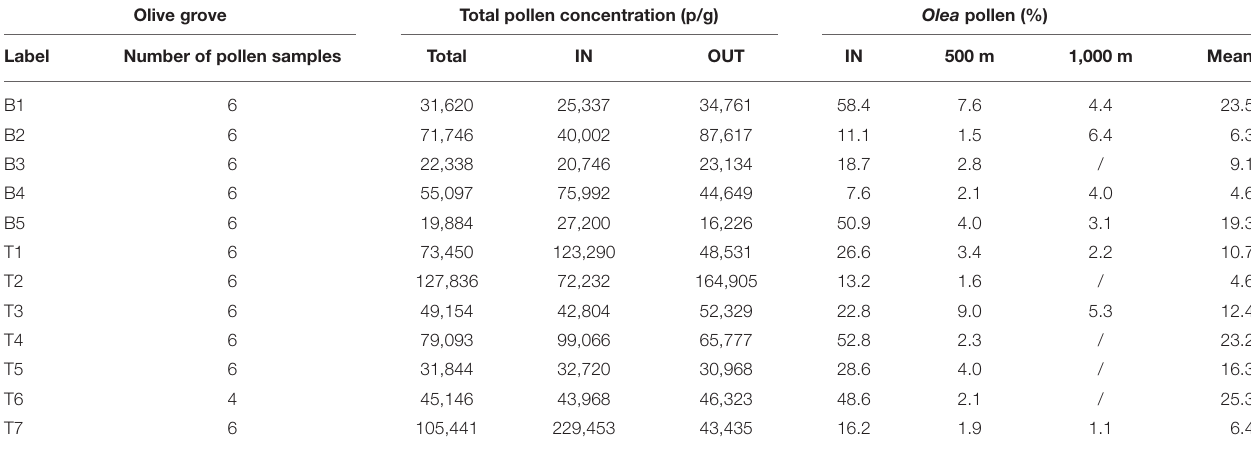
TABLE 2 | Results of the pollen analyses: concentration (p/g = pollen per gram) of all the pollen grains found in the soil surface samples, and the percentages of Olea pollen counted in the IN and OUT samples of each plantation. Olive grove Total pollen concentration (p/g) Olea pollen (%) Label Number of pollen samples